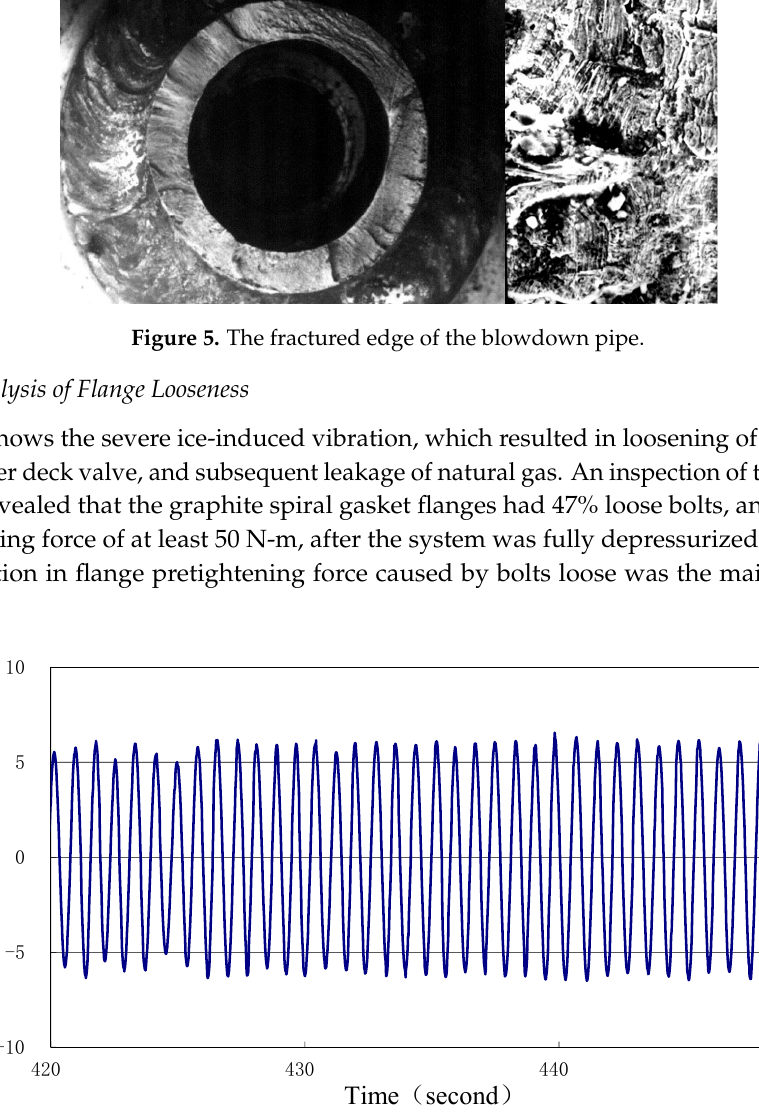
Figure 4. Partial structure of the blowdown pipe.